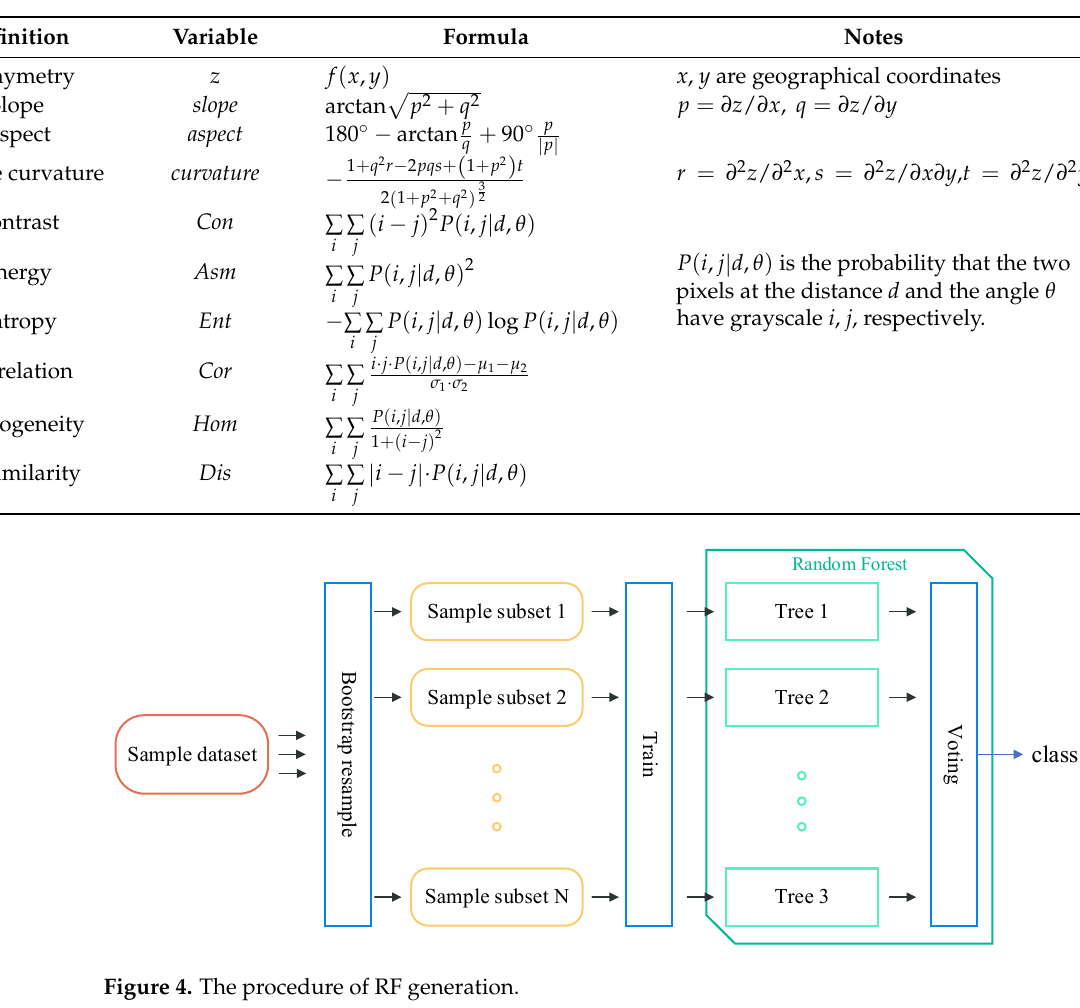
Table 1. Topographic and geomorphic features.